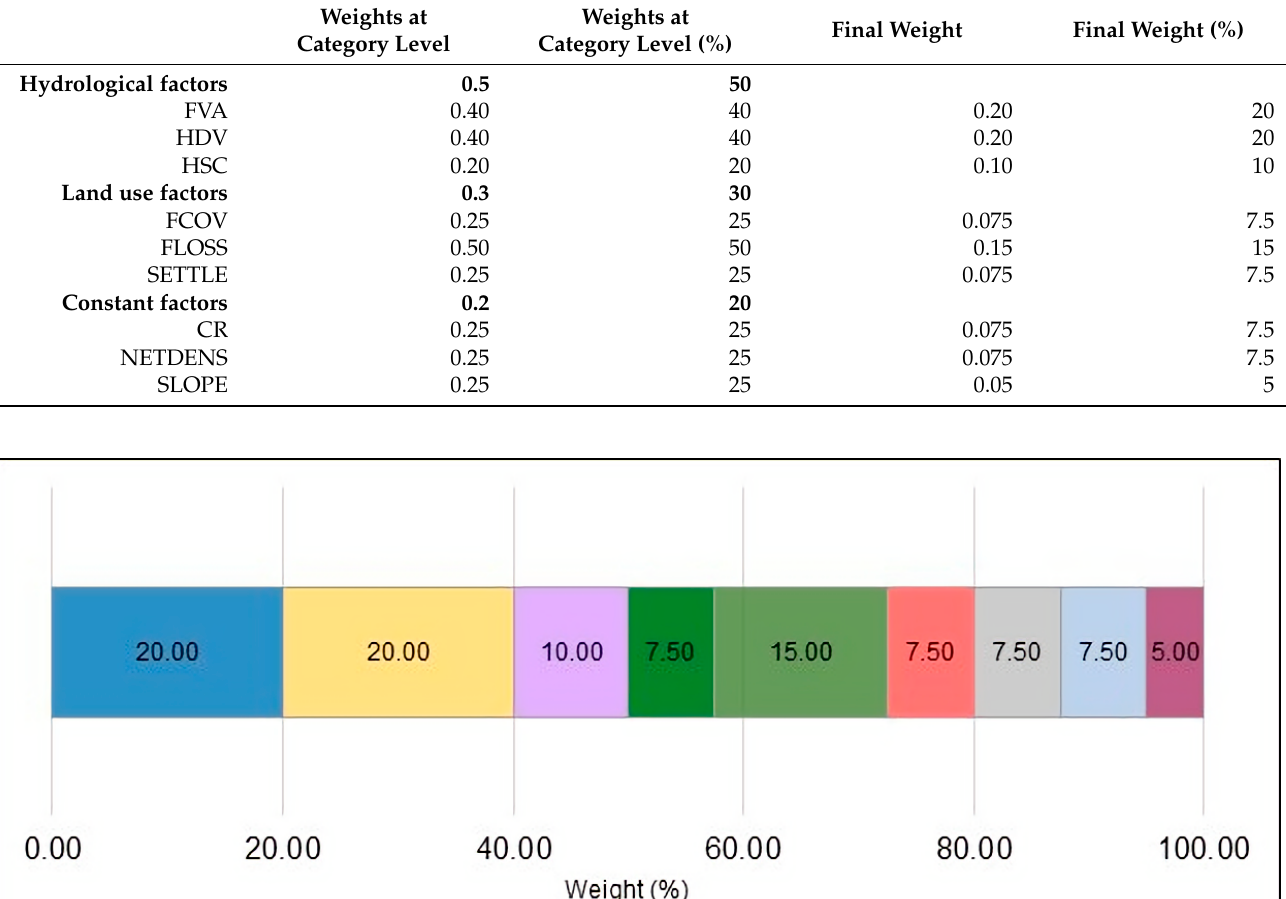
Table 4. The category and overall weights of the hydrological, land use, and constant factors.